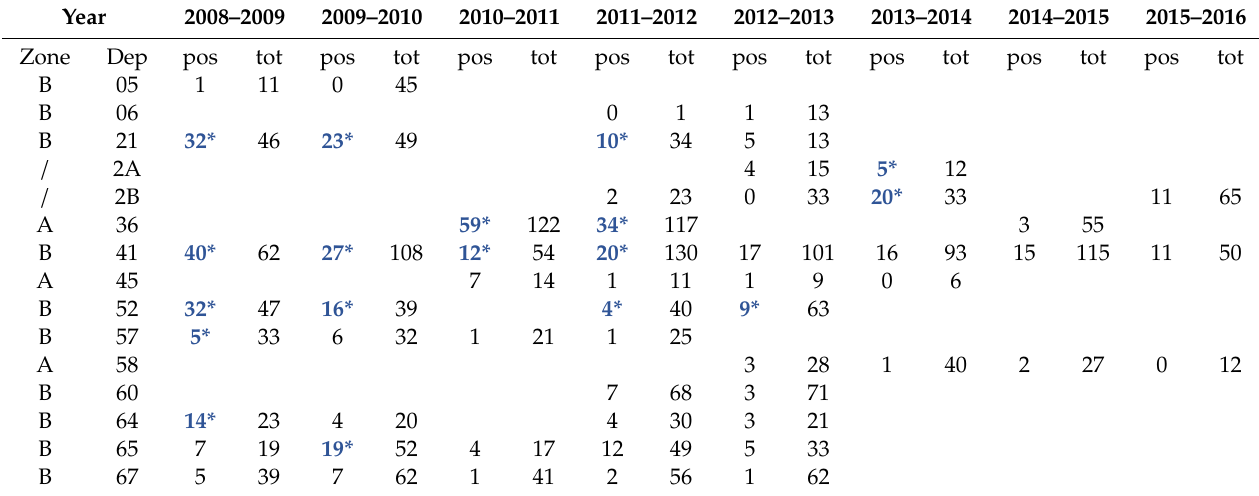
Table 2. ELISA and PCR results observed among red deer (RD) from 15 departments sampled from 2008 to 2015. ( a ) The features in nn* indicate that at least one seropositive was observed in young red deer (less than 2 years old). ( b ) “pos” are indicated in bold. The gray-colored cells indicate that BTV8 or BTV1 (light gray), or both (dark gray), were present in the domestic flocks within the same department at that time. “Dep” corresponds to the department number, “pos” or “neg” corresponds to the number of positive or negative results, and “tot” corresponds to the total of samples with a conclusive result. (a) ELISA results observed among 3065 RD